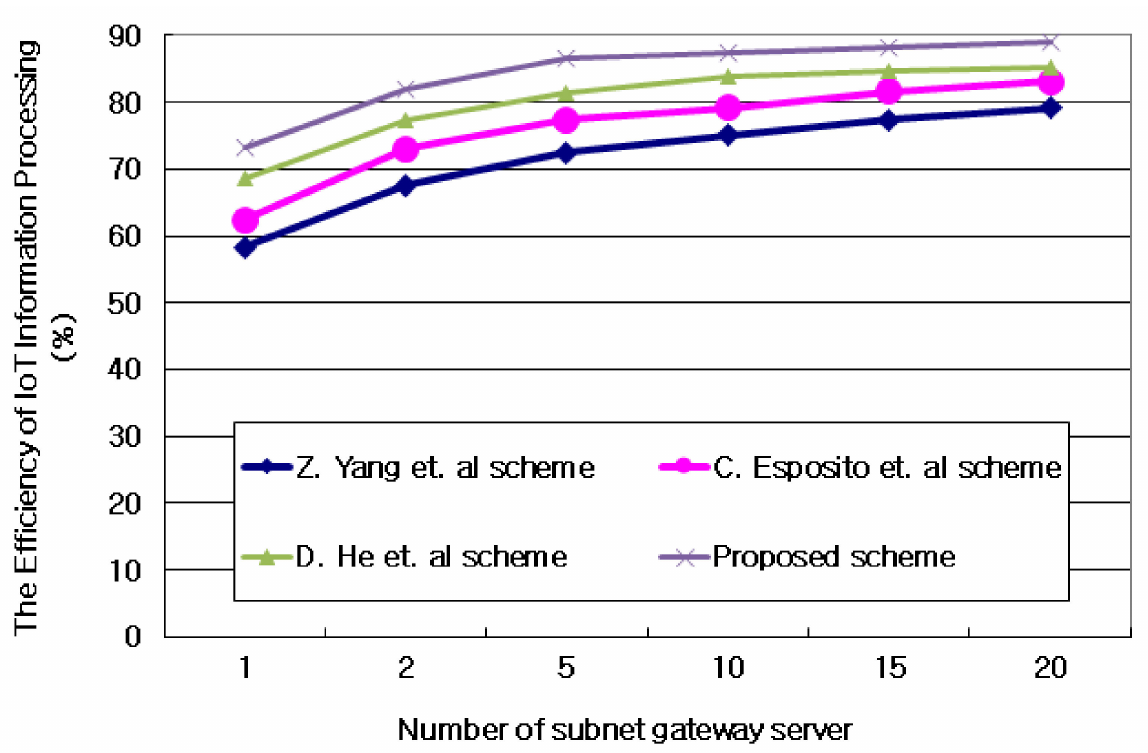
Figure 8. Evaluating the efficiency of IoT information processing in subnet gateway servers.